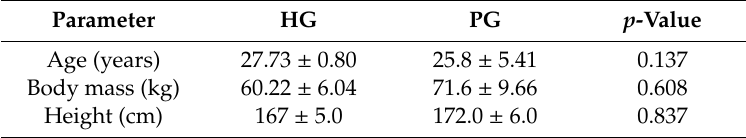
Table 3. Anthropometric data of the subjects and p-value of relationship between the healthy group (HG) and ACLR group (PG). Values stated as mean ± standard